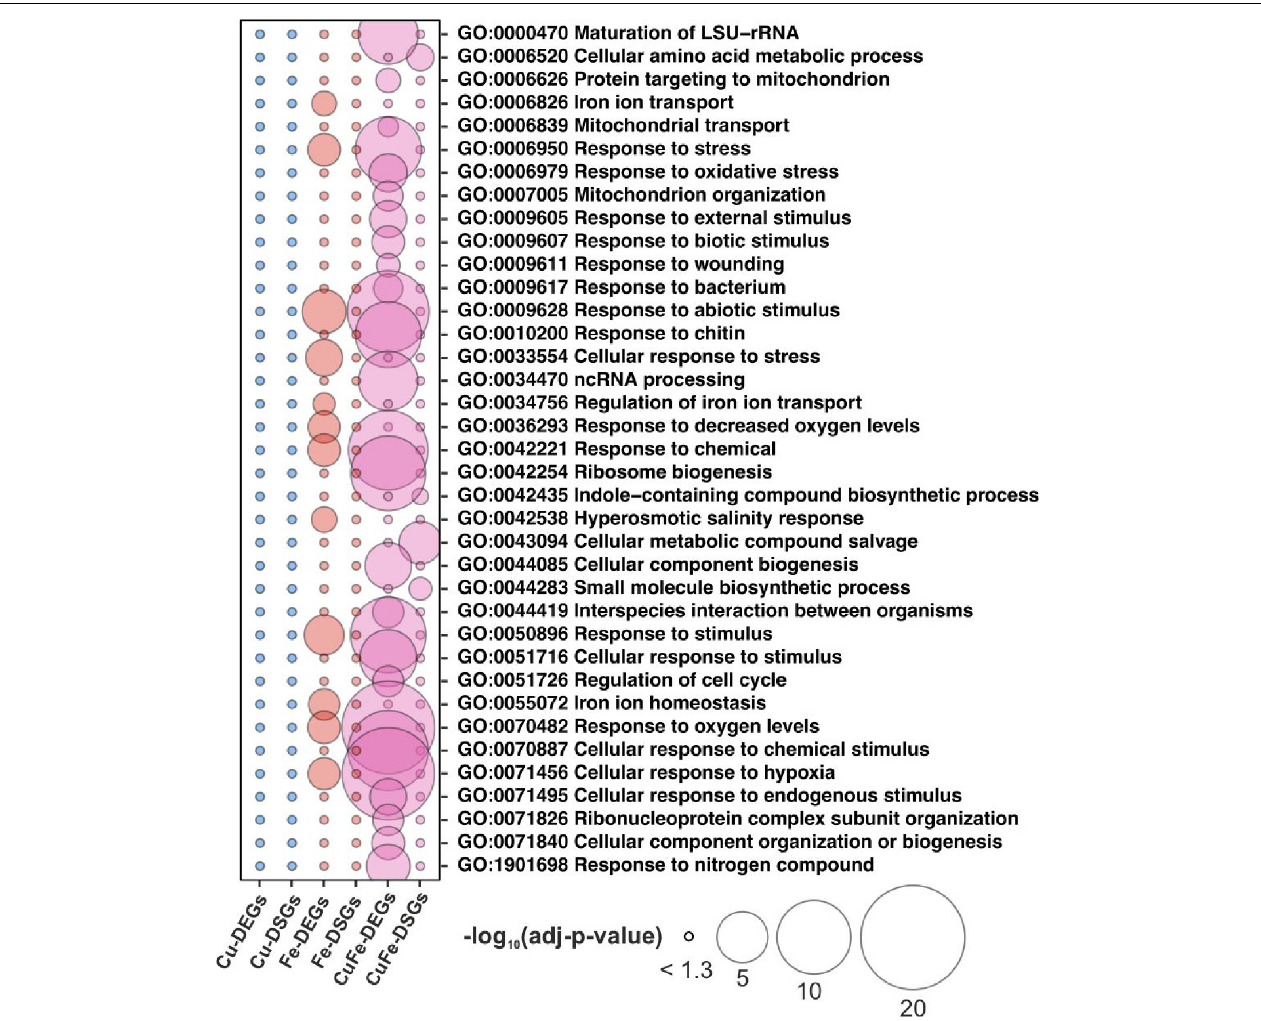
FIGURE 2 | Functional annotation of specific changes in transcriptome and alternative splicing under single and simultaneous copper and iron deficiency. Bubble plot depicting differences in specific DEGs and DSGs detected under single and double copper and iron deficiency treatments (Cu, Fe, and CuFe, respectively). Specific DEGs and DSGs were analyzed for significant gene ontology (GO) term enrichment (adjusted- p -value ≤ 0.05, Fisher’s test) and filtered for redundancy by REVIGO (filter 0.5). The size of the bubble is proportional to the –log10-transformation of the adjusted- p -value in the Fisher’s